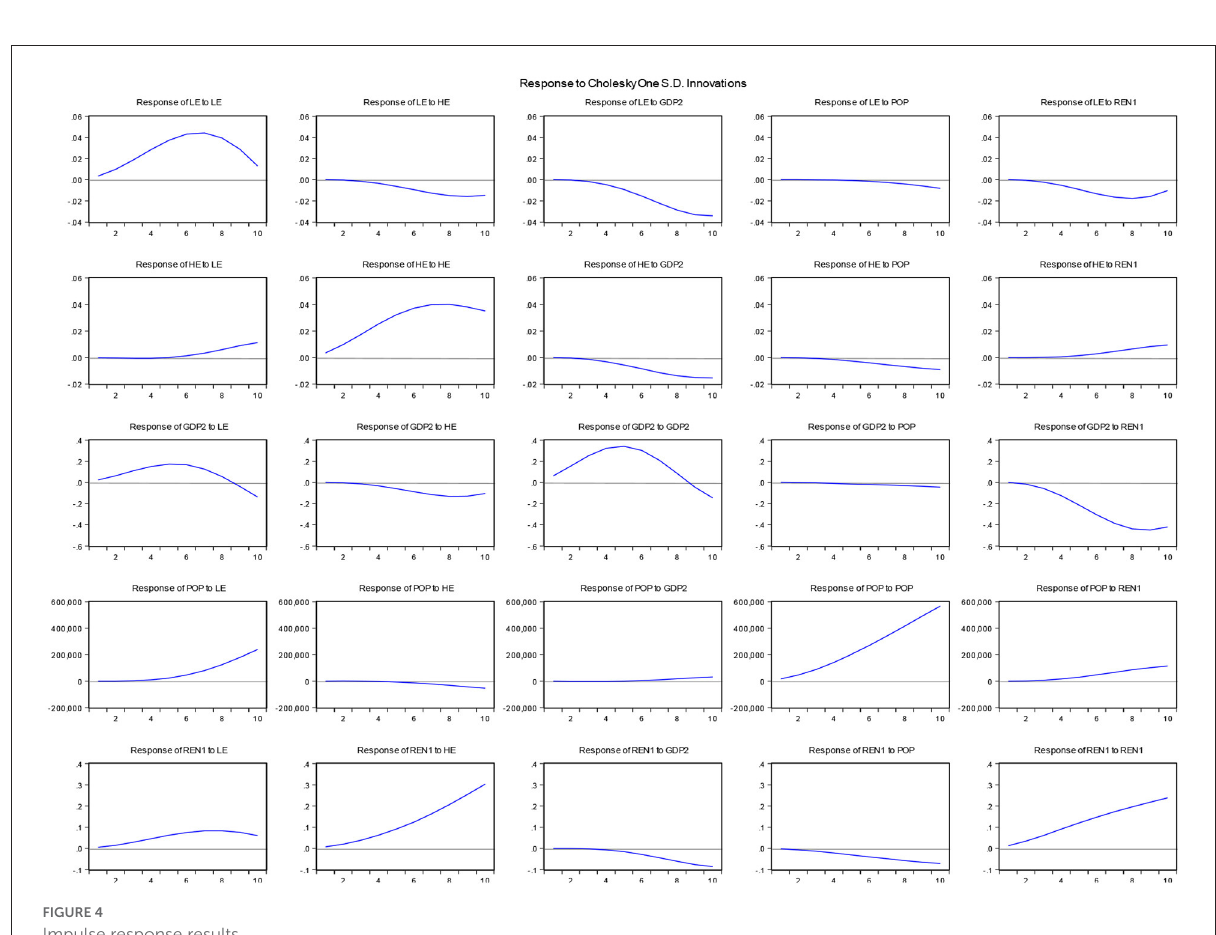
of cointegration. The cointegration requires the selection of optimal lag length; we select the Schwarz information criterion (SC) and Akaike information criterion (AIC) to choose the optimal lag length. In Tables 2 and 3, the trace statistics and